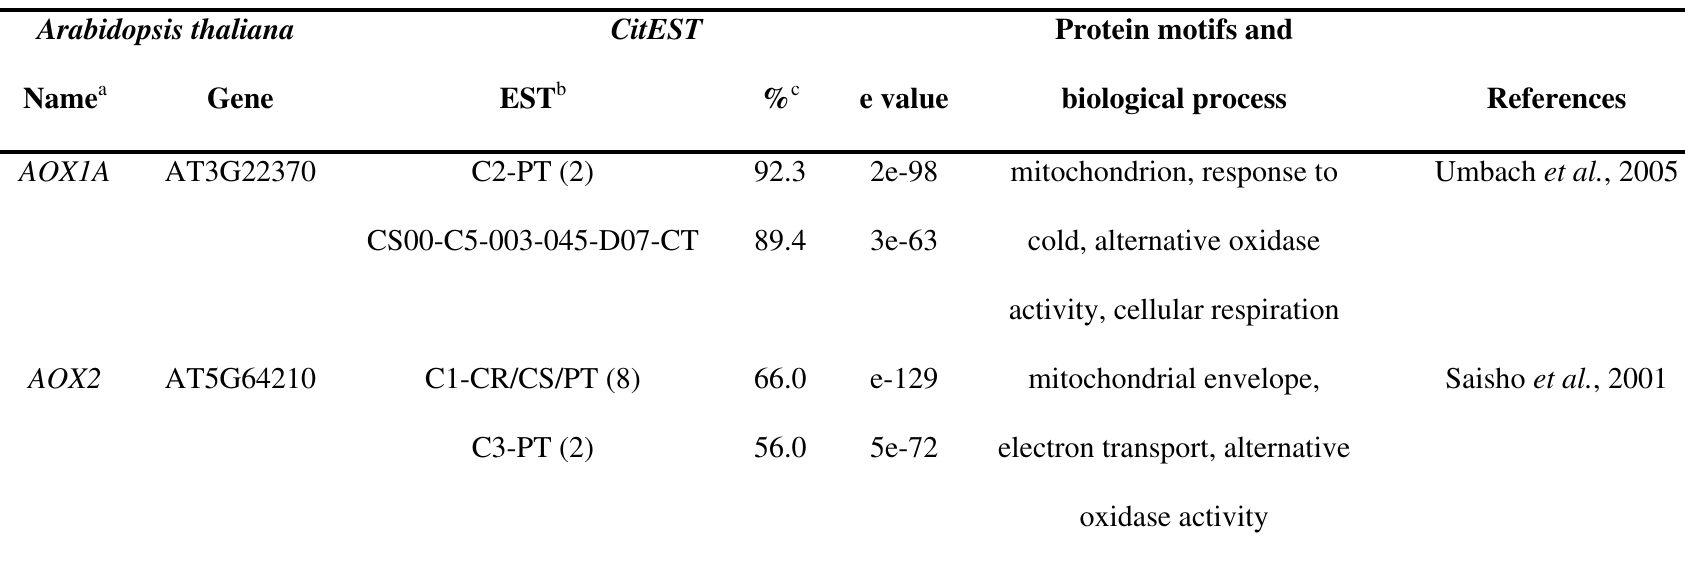
Table S10 – Citrus ESTs with homology to alternative oxidase protein families from Arabidopsis thaliana